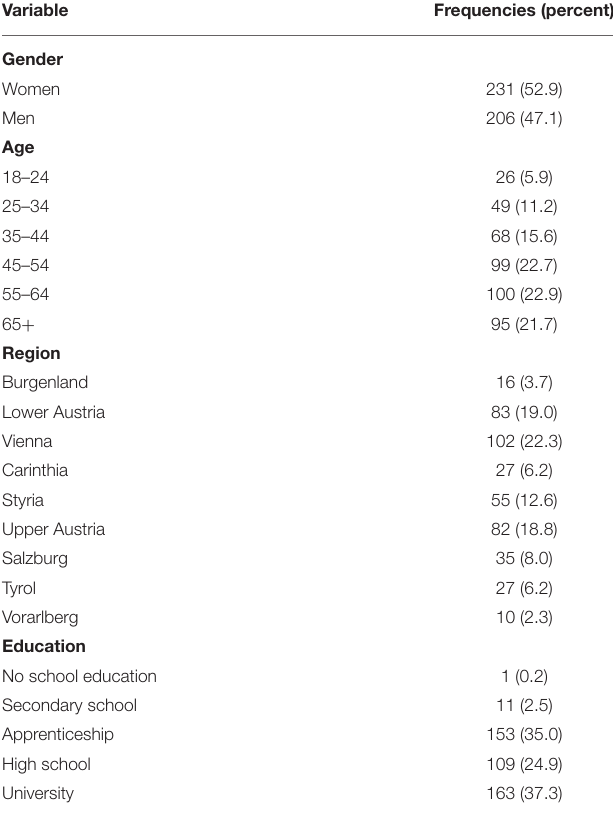
TABLE 1 | Study sample characteristics ( N =